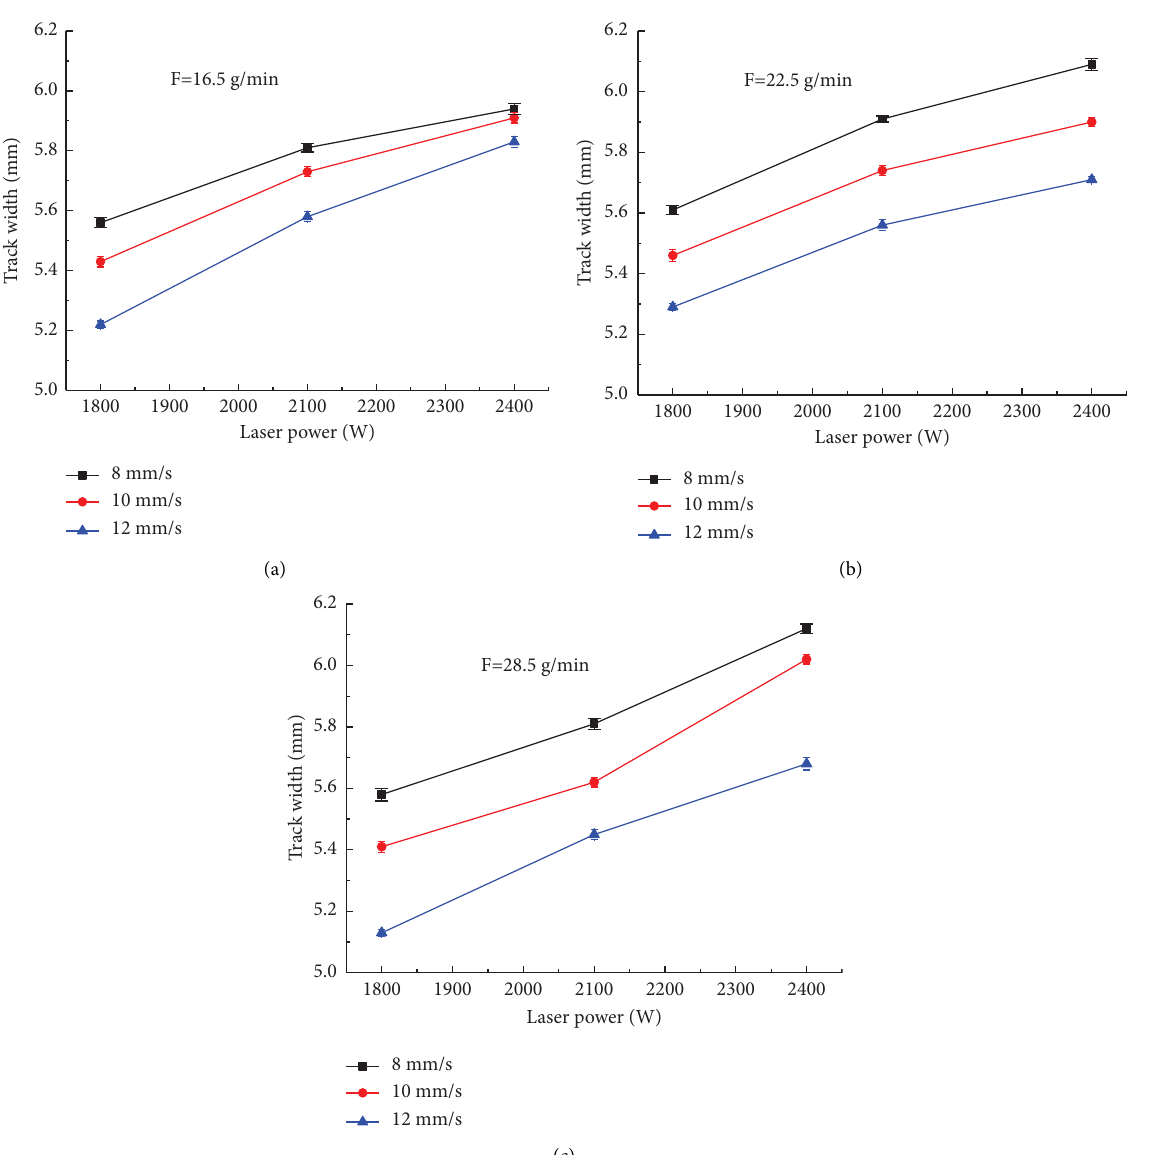
Figure 6: Variation of track width with laser power and scan speed at given powder feed rate. (a) F � 16.5g/min; (b) F � 22.5g/min; (c) F �